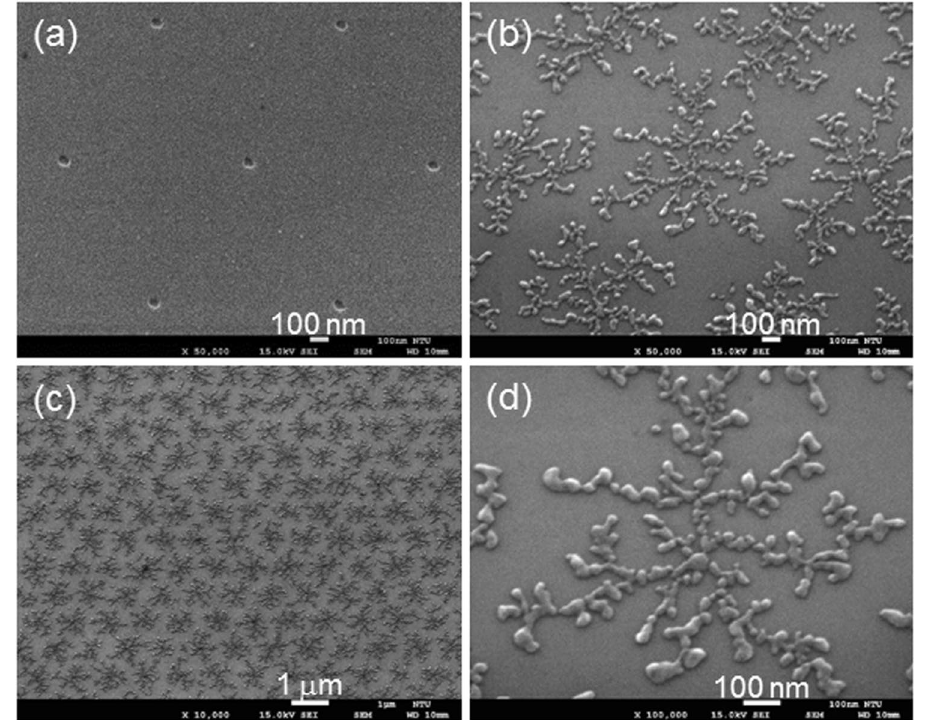
Figure 13. ( a ) SEM image of a hole array on a SiO 2 mask. ( b ) SEM image showing the Ag NP structure after Ar + ion bombardment, SiO 2 liftoff, Ag deposition, and 16-hour illumination of the 395-nm LED. ( c ) SEM image of a larger area to demonstrate the patterned array of Ag BT. ( d ) Magnified SEM image of the central BT in part ( b